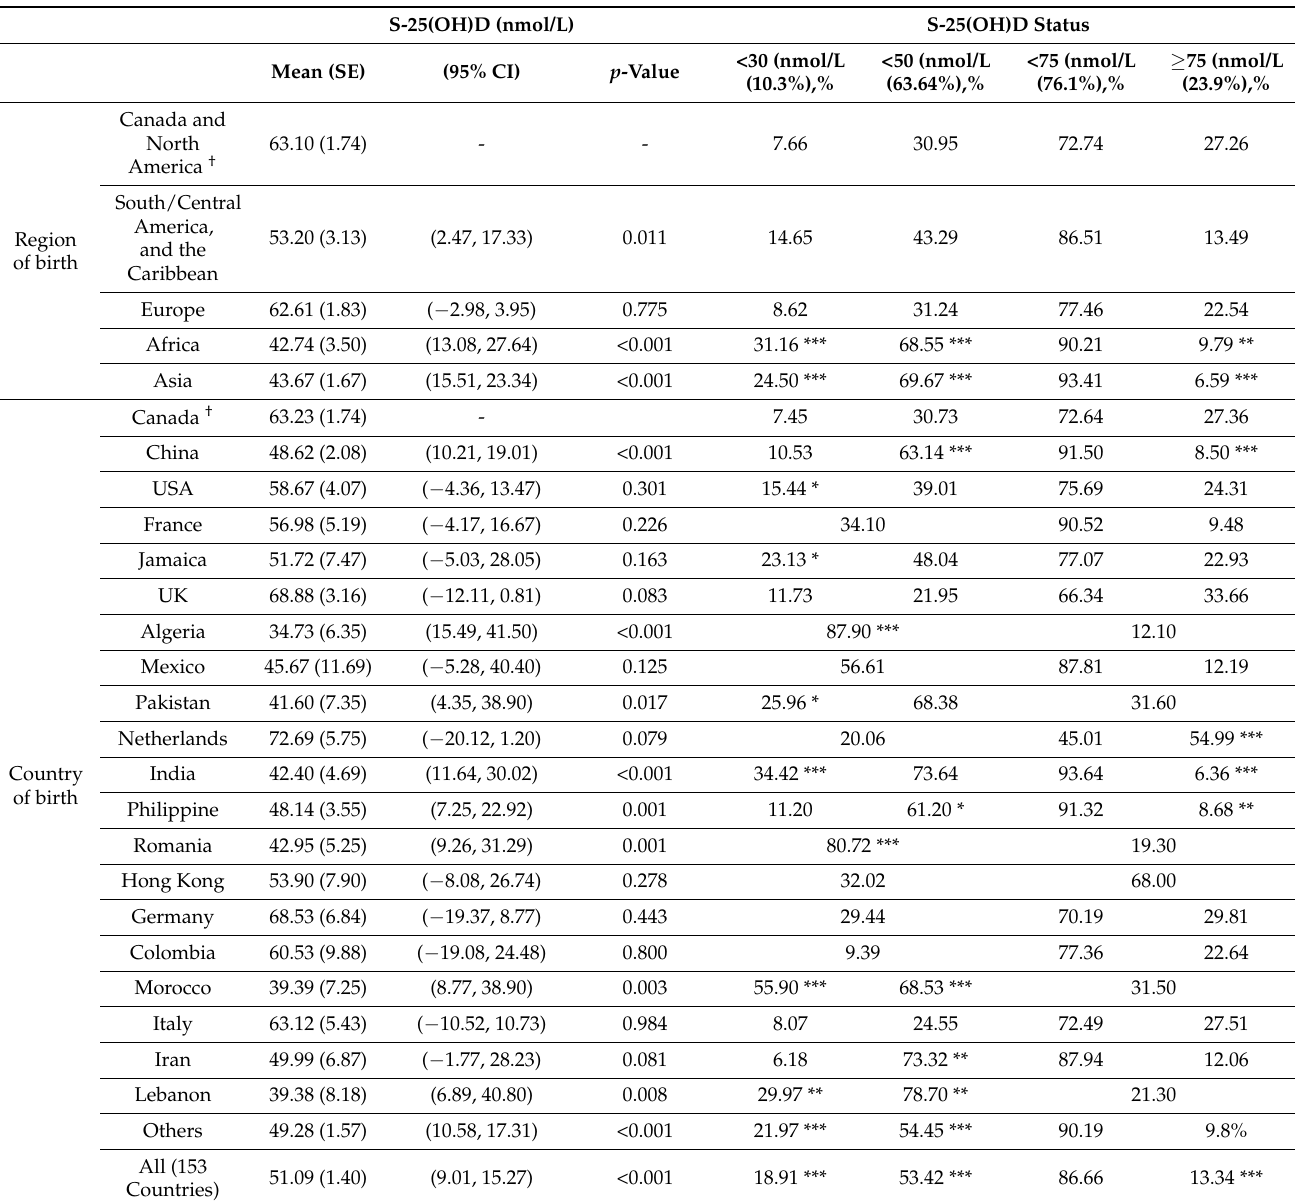
Table 4. Weighted mean S-25(OH)D (nmol/L) and vitamin D status by geographical region and country of birth using Cycles 3 and 4 of Canadian Health Measures Survey